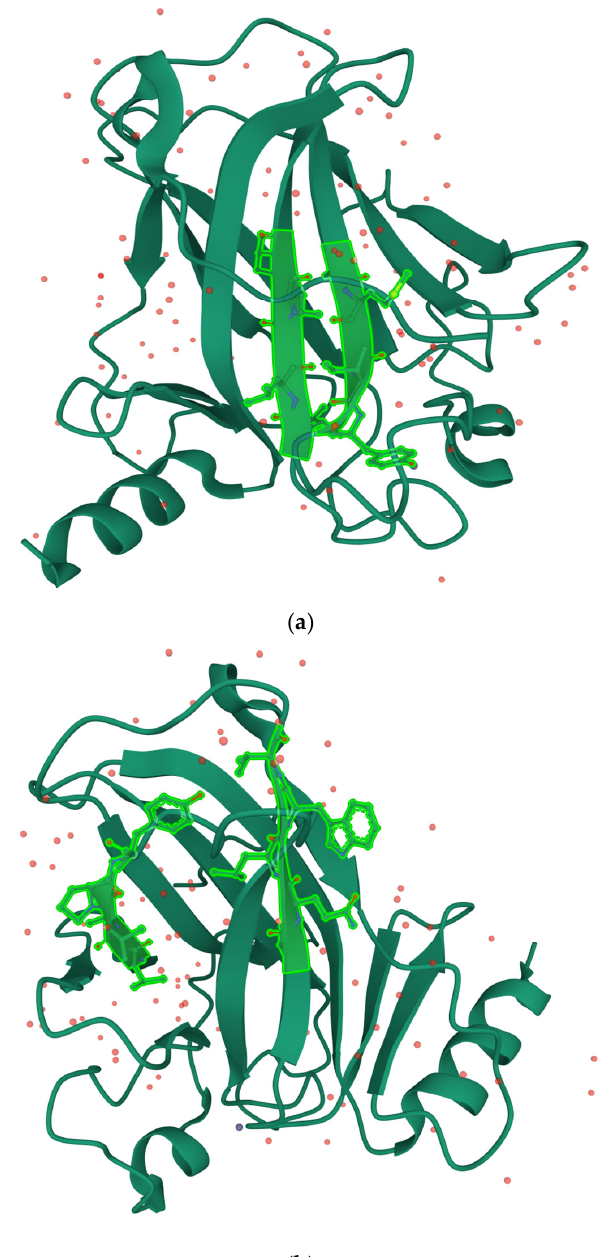
Figure 2. ( a ) The best possible primary contact, C1, on the structure of core p53 (PDB 2OCJ); ( b ) contact C2 is on the same structure. As can be observed in the figures, C1 is a good contact on the 3D structure, while C2 does not, as the side chains of the two segments that define it are not close in the folded structure. The figures were prepared using Mol* [60].